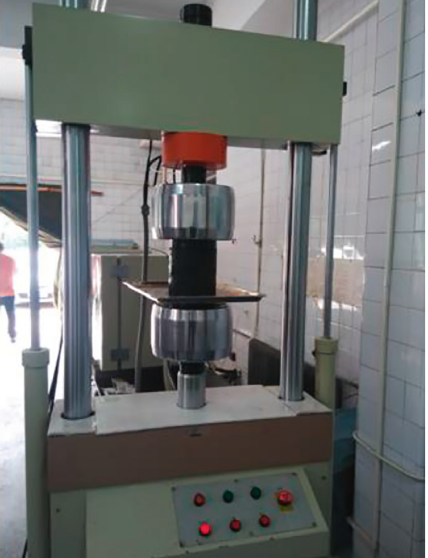
Figure 7: Gradation curves of SDS and FDS.